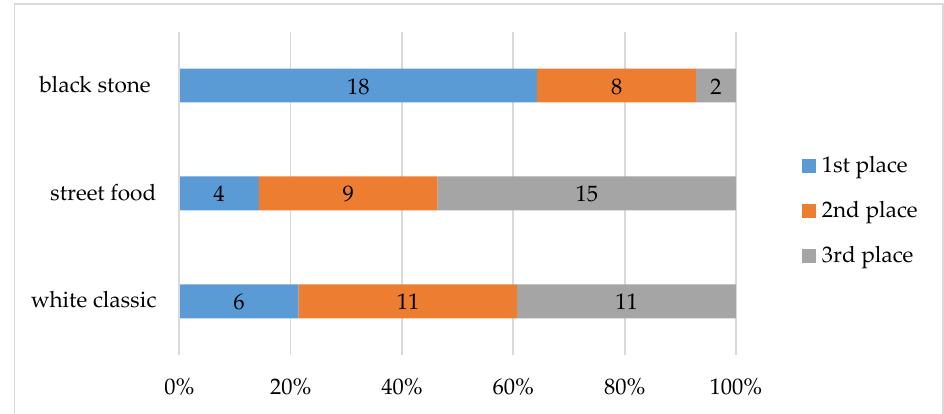
Figure 12. Overall evaluation of individual variants of waffles served in different ways.